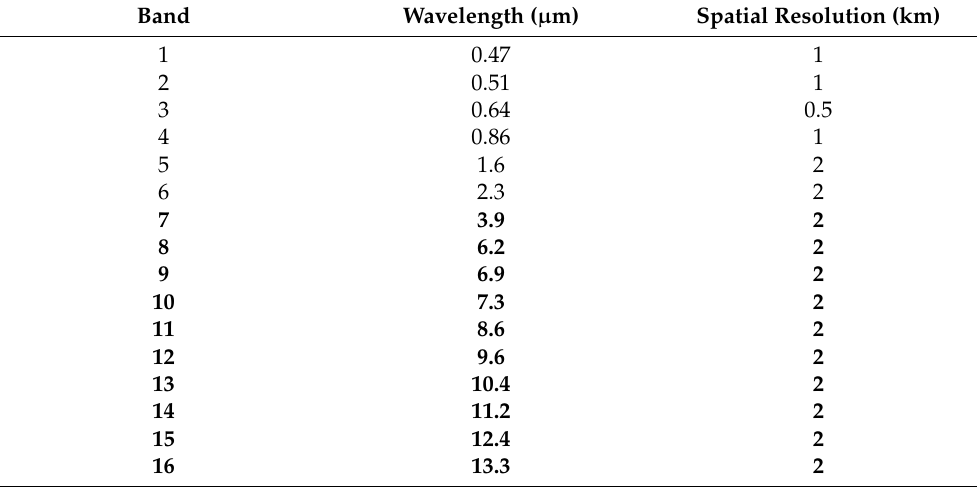
Table 1. The AHI bands specifications.